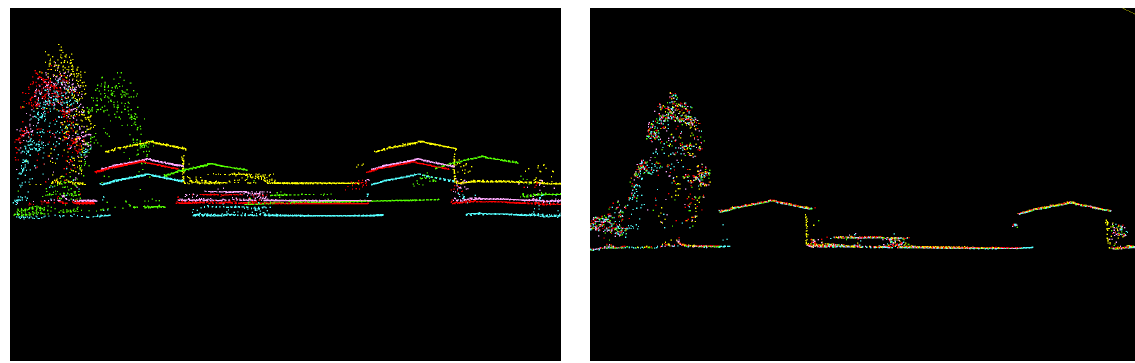
Figure 12. Velodyne VLP16 LiDAR before ( left ) and after ( right ) LIBAC.